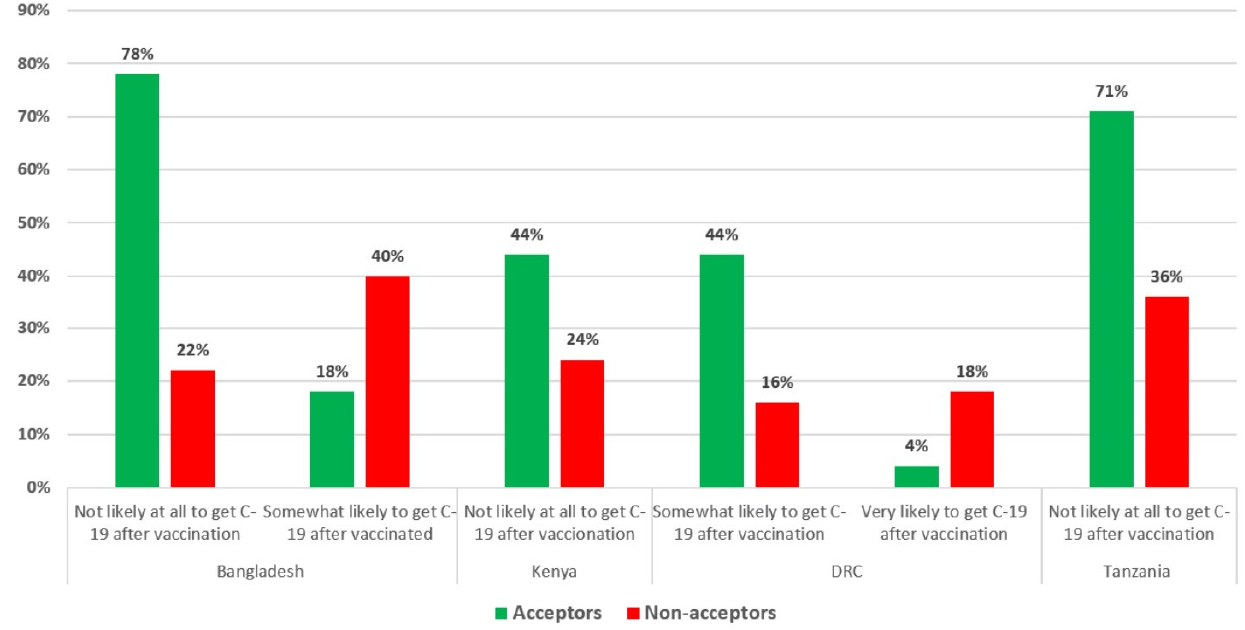
Figure 3. Acceptors vs. Non-acceptors: Perceived action efficacy of COVID-19 vaccines by country.